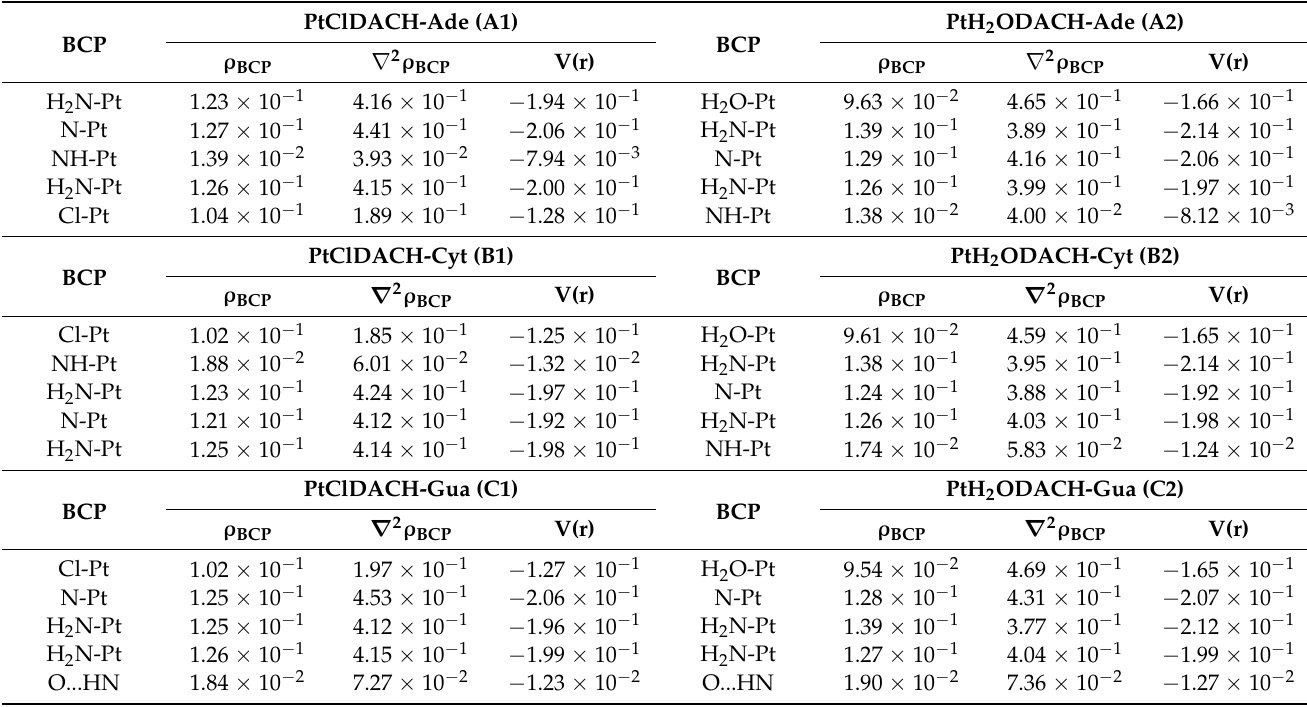
Table 6. Bond Critical Points (BCPs) and potential energy density obtained at the MN15/def2-TZVP level of theory for six selected complexes. Electron density ρ BCP is given in e * a 0 − 3 atomic units, and its Laplacian ∇ 2 ρ BCP in e * a 0 − 5